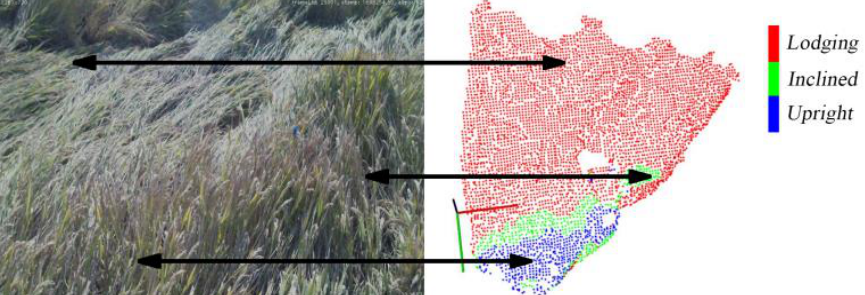
Figure 13. Wheat lodging point cloud map (both ends of the arrow indicate the same location).